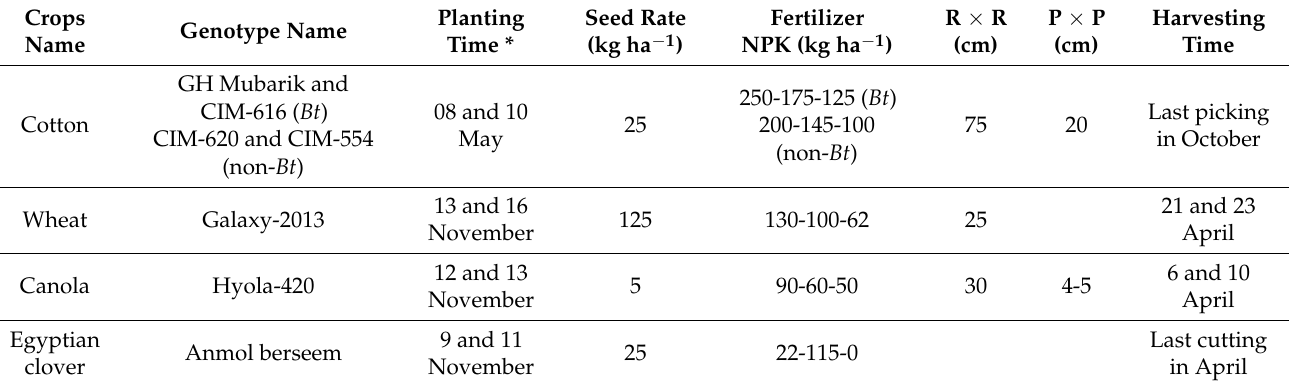
Table 2. The production practices used for the cultivation of cotton and winter crops used in